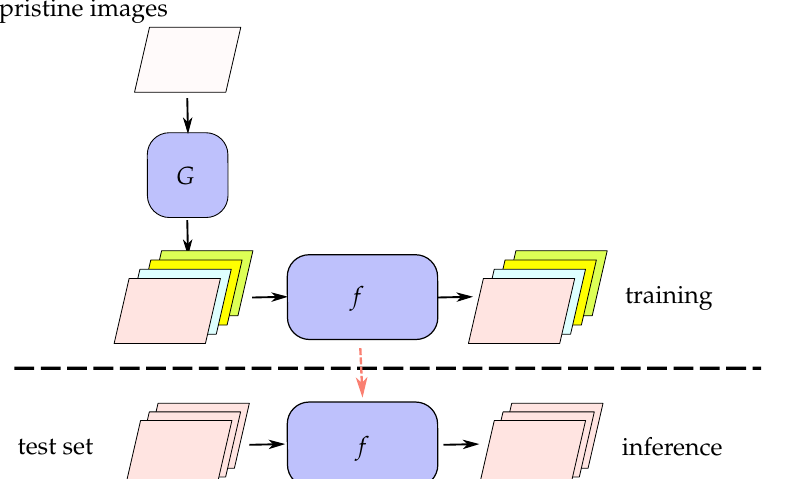
Figure 1. Previous methods of fake sample syntheses. The pristine images are used to generate fake images based on color jitter, resizing, sharpening, and translation using a fake image synthesizer G . The orange dashed line represents the use of trained weights during the inference